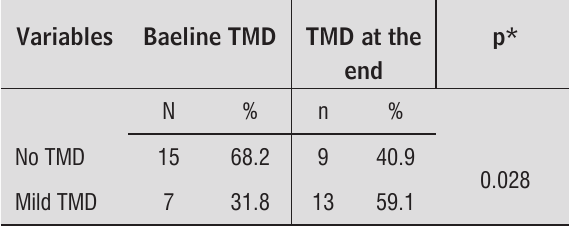
Using only one side of